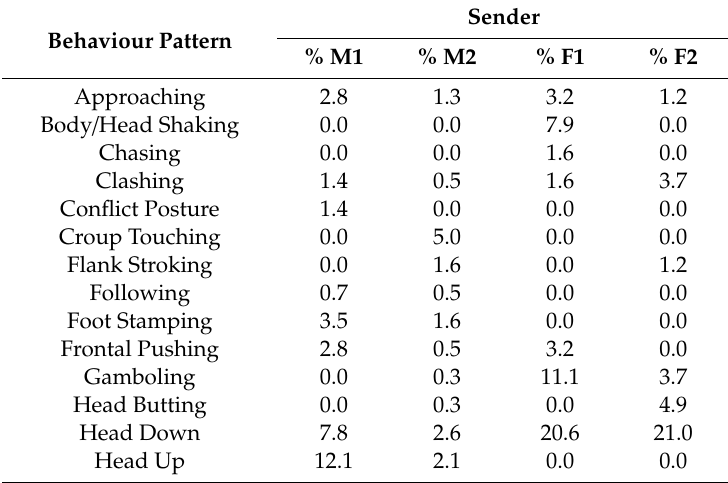
Table 3. Occurrence of behaviour patterns of the mainland serow. M1–F1, pair of Dusit; M2–F2, pair of Khao Kheow. Only the sex of the sender is indicated, as the animals were kept in heterosexual